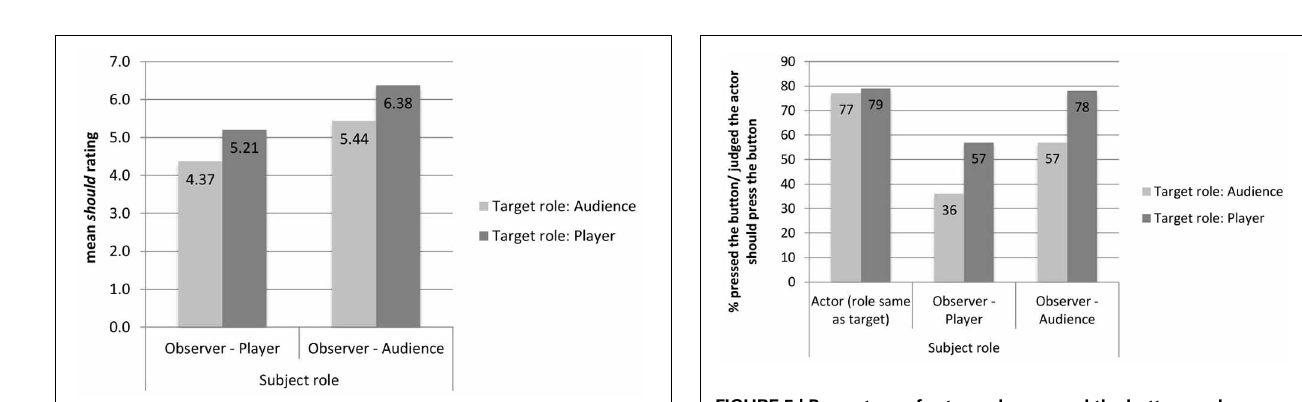
actor should press the button ( M = 5 . 92) than the players ( M = 4 . 79), F ( 1 , 104 ) = 5 . 12, p = 0 . 026, η 2